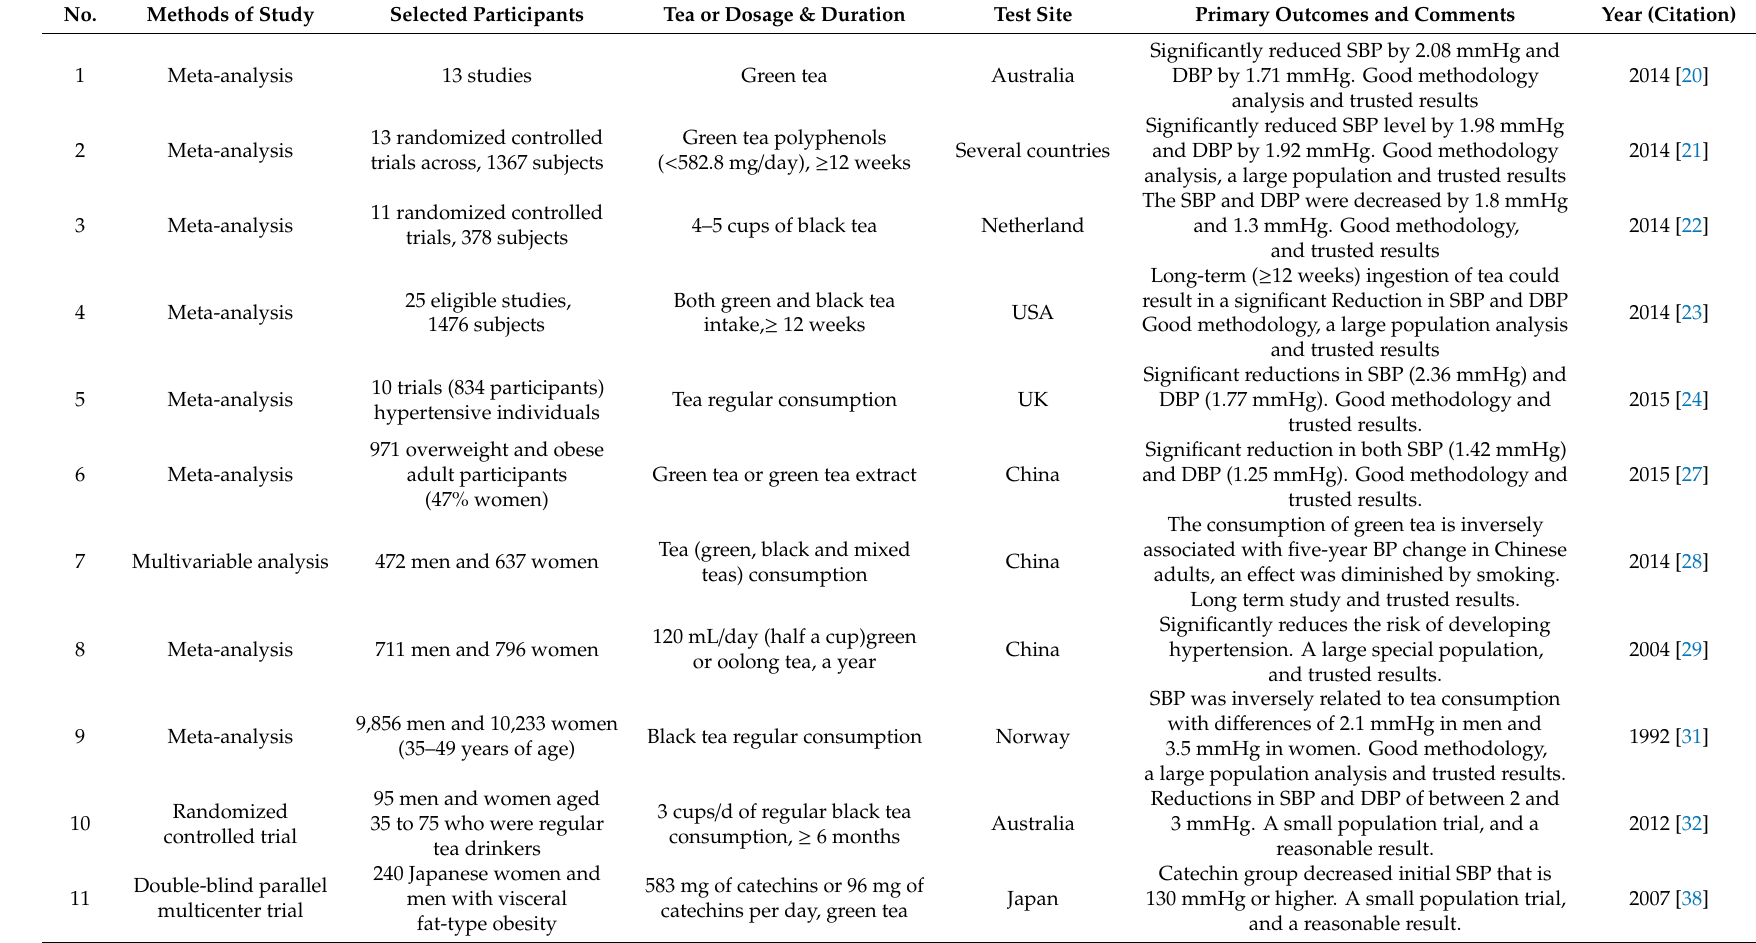
Table 1. Blood pressure-lowering e ff ects of tea in human